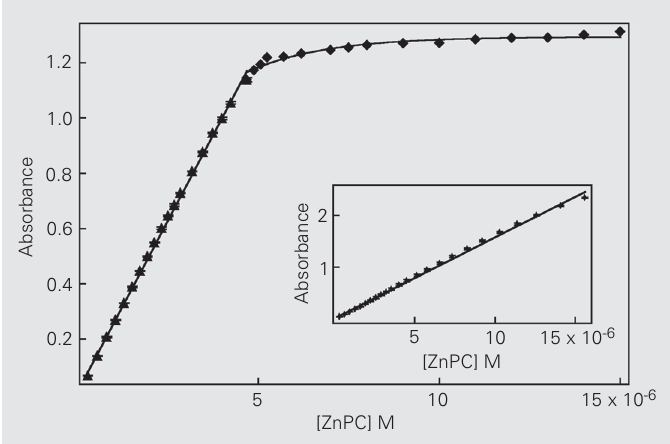
Figure 2. Variation in the absorbance (673 nm) as a function of zinc phthalocya- nine (ZnPC) concentration in DMPC liposomes and in organic solution (pyridine) in the